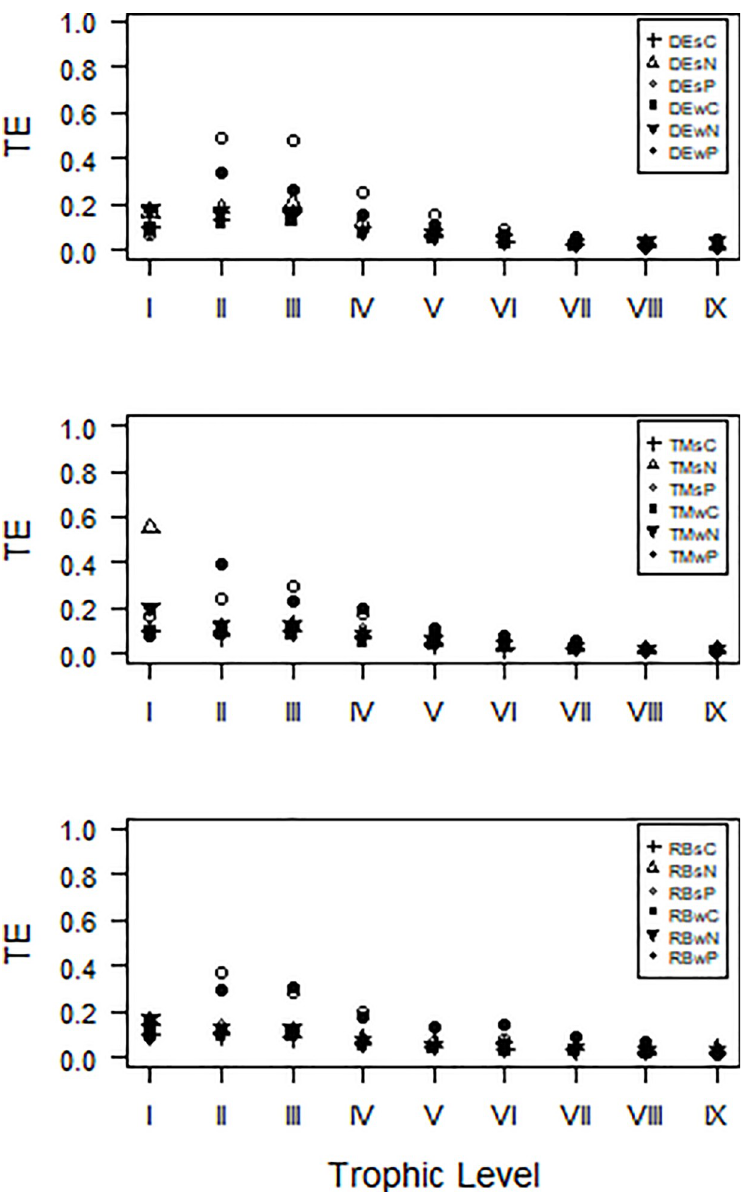
Fig 3. Trophic transfer efficiencies (as fraction) between discrete trophic levels of each nutrient (C, N, P) in each region (DE, TM, RB) and season (s, w).